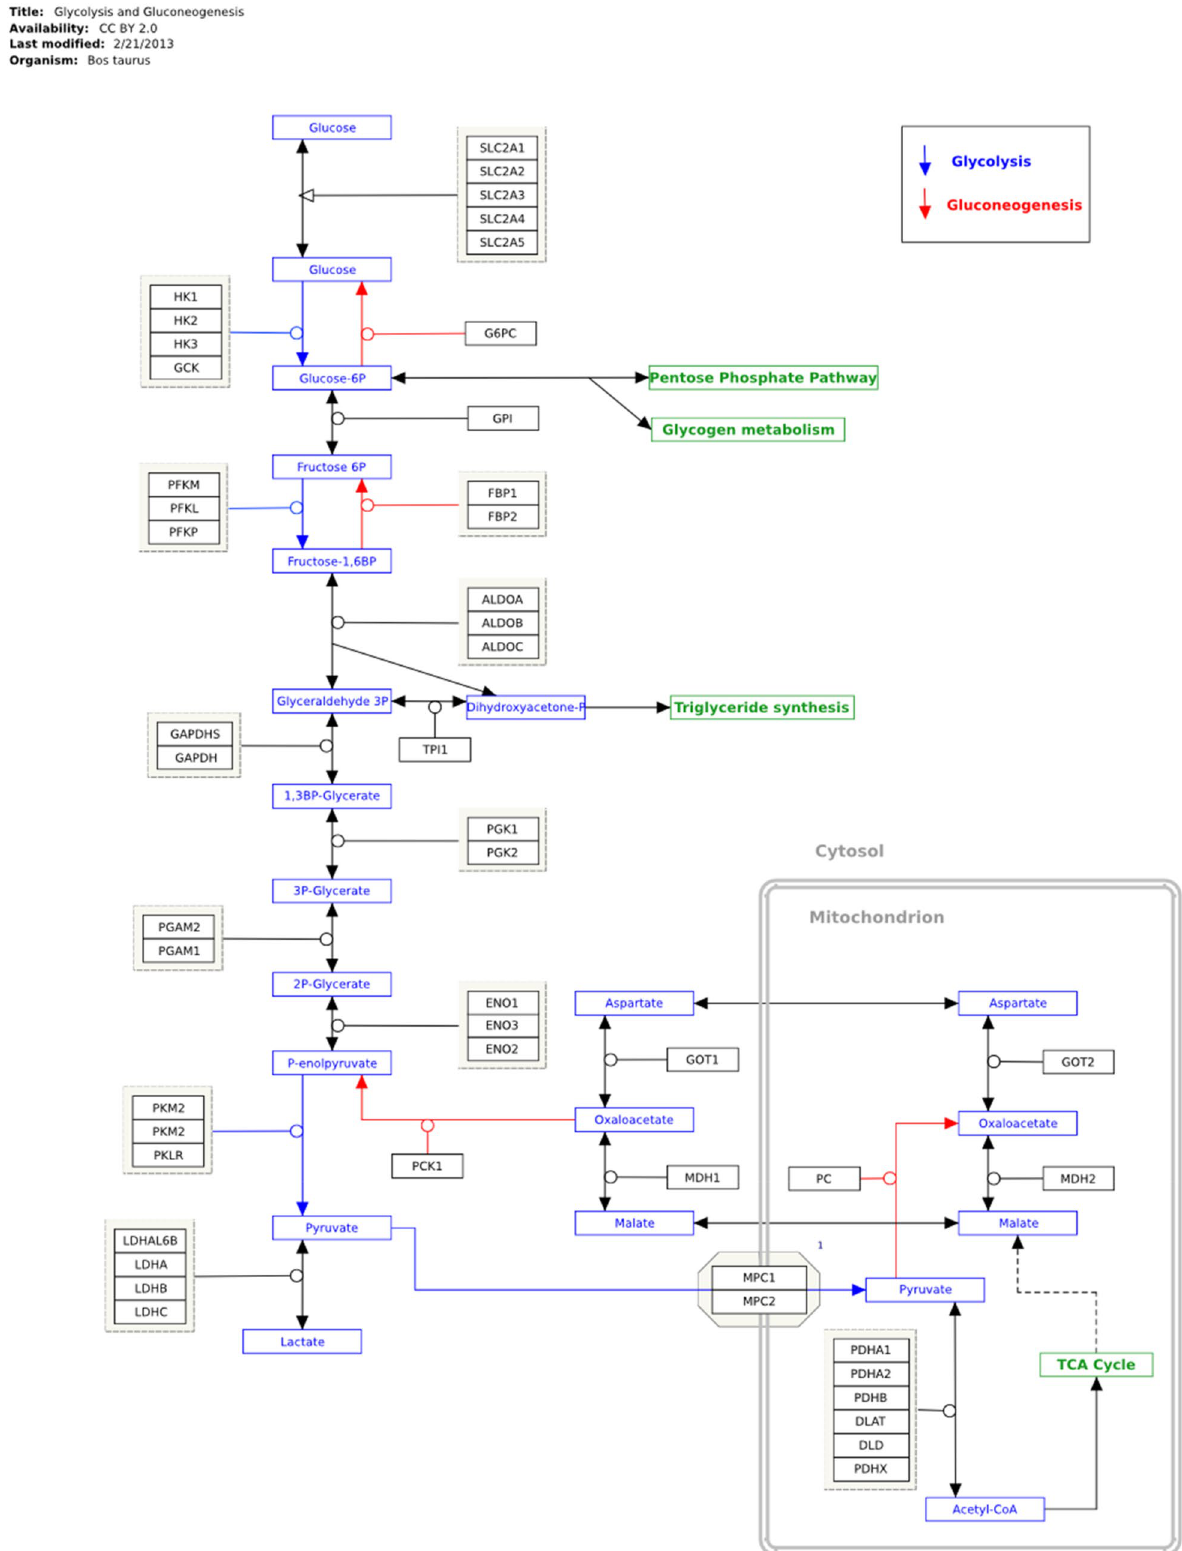
Figure 2. Expression protein profile encoding enzymes in glycolysis and gluconeogenesis pathway. KEGG key: EC 4.1.2.13: Fructose-bisphosphate aldolase (ALDOB); EC 5.3.1.1: Triosephosphate isomerase (TPI); EC 1.2.1.12: Glyceraldehyde-3-phosphate dehydrogenase (GAPDH); EC 5.4.2.4: Phosphoglycerate mutase (PGAM); Alpha-enolase (ENO1); EC 4.2.1.11 Beta-enolase (ENO3); EC 2.7.1.40 Pyruvate Kinase (PKM); EC 1.1.1.27 L-lactate dehydrogenase